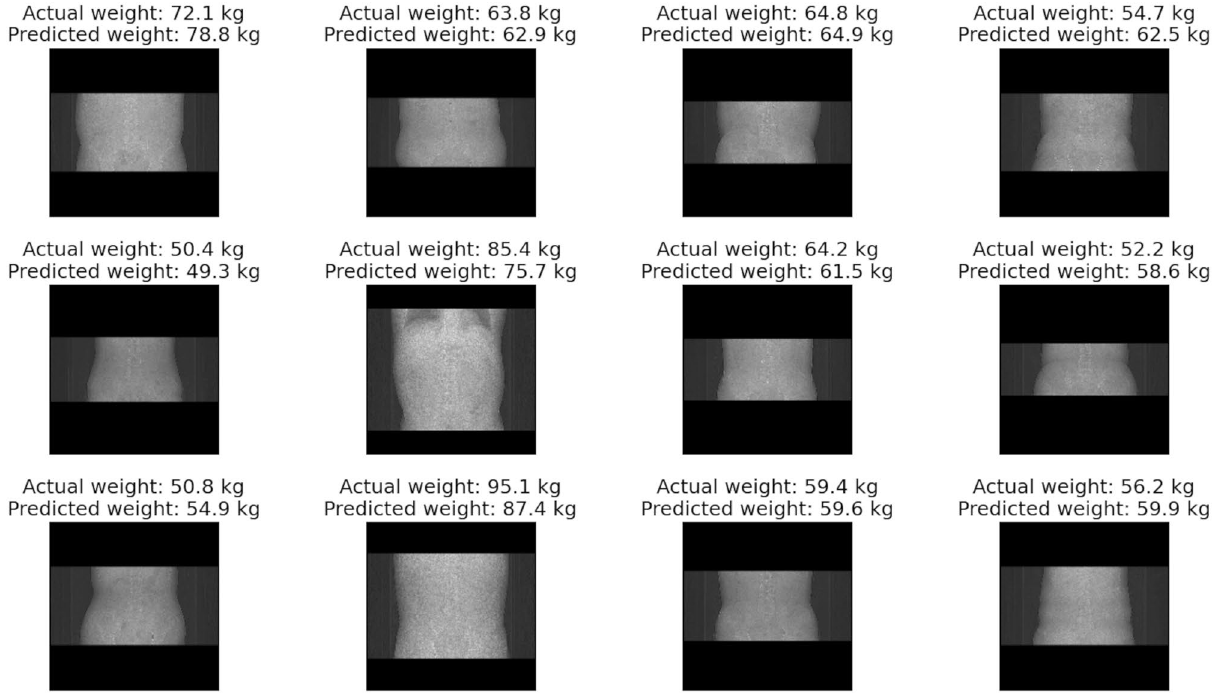
Figure 6. Representative cases of our CNN-based approach for predicting body weight in abdominal datasets. The upper row shows the actual body weight, and the lower row shows the predicted body weight from our CNN-based